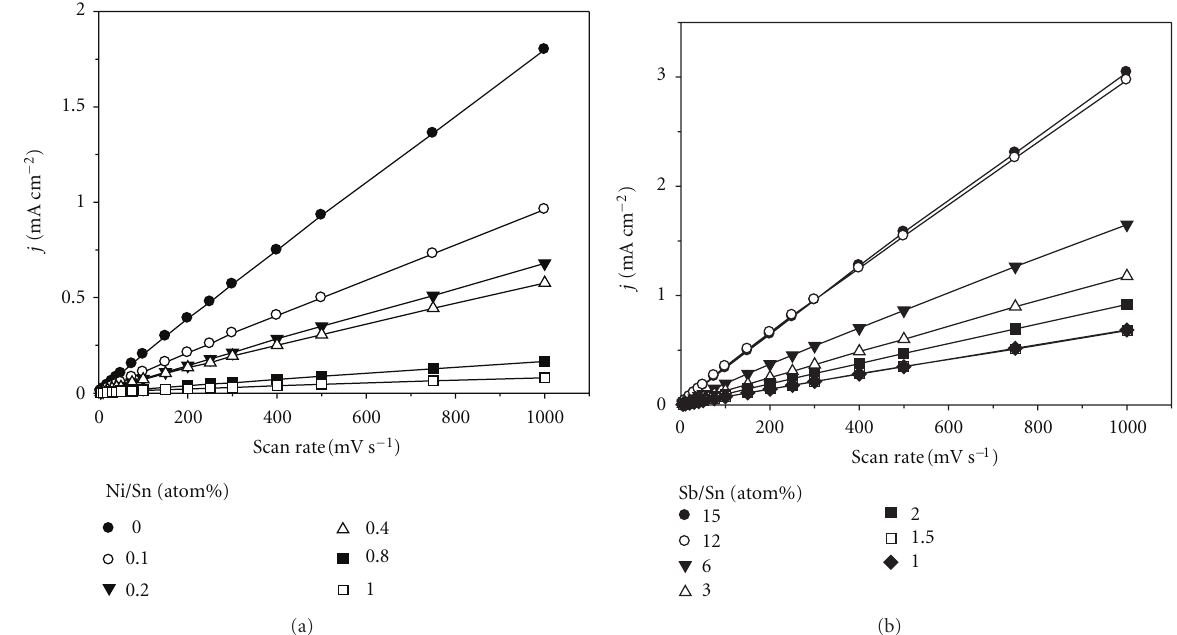
Figure 3: Variation of capacitive current density at 1.0 V with the potential scan rate measured between 0.95 and 1.05V for (a) Ti / SnO 2 - Sb(2%)-Ni( x %) and (b) Ti / SnO 2 -Sb( x %)-Ni(0.2%) electrodes in 0.1M H 2 SO 4 solution. The values in parentheses are atomic ratios with respect to Sn.